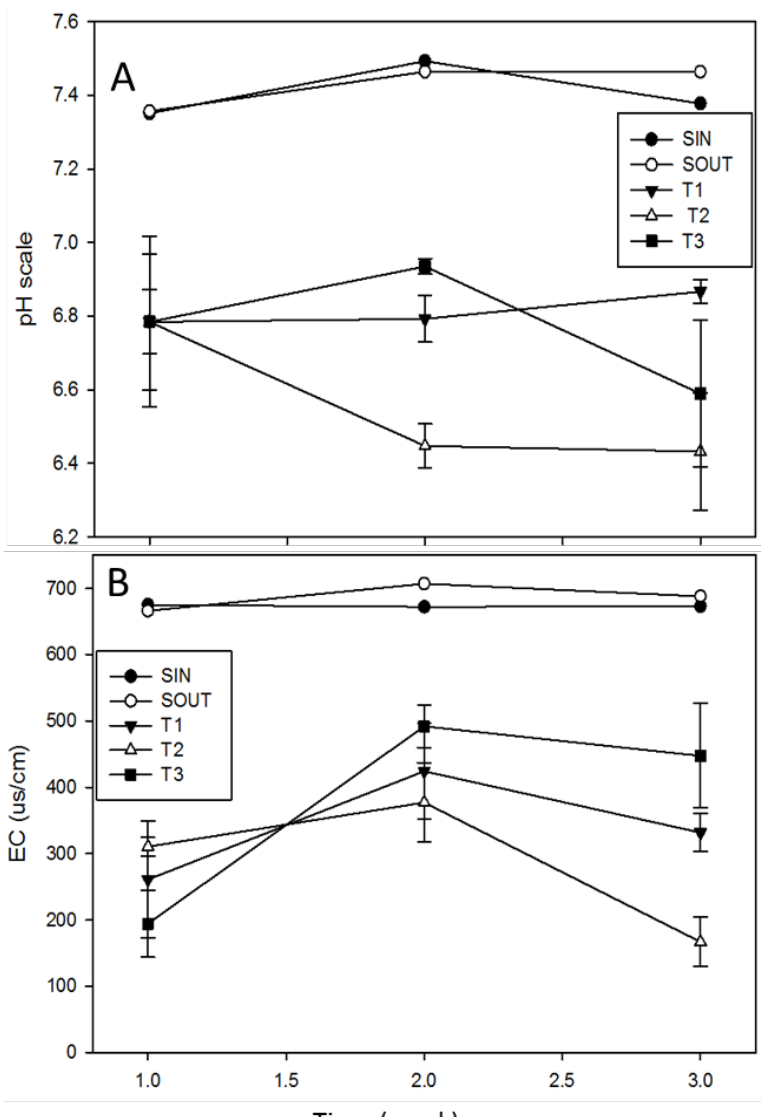
Figure 1. pH ( A ) and electrical conductivity (EC); ( B ) values of wastewater samples from septic tank inlet (SIN) and outlet (SOUT), in addition to water samples from lysimeters installed 15 cm below the drainfield trenches (T1, T2 and T3). Wastewater and